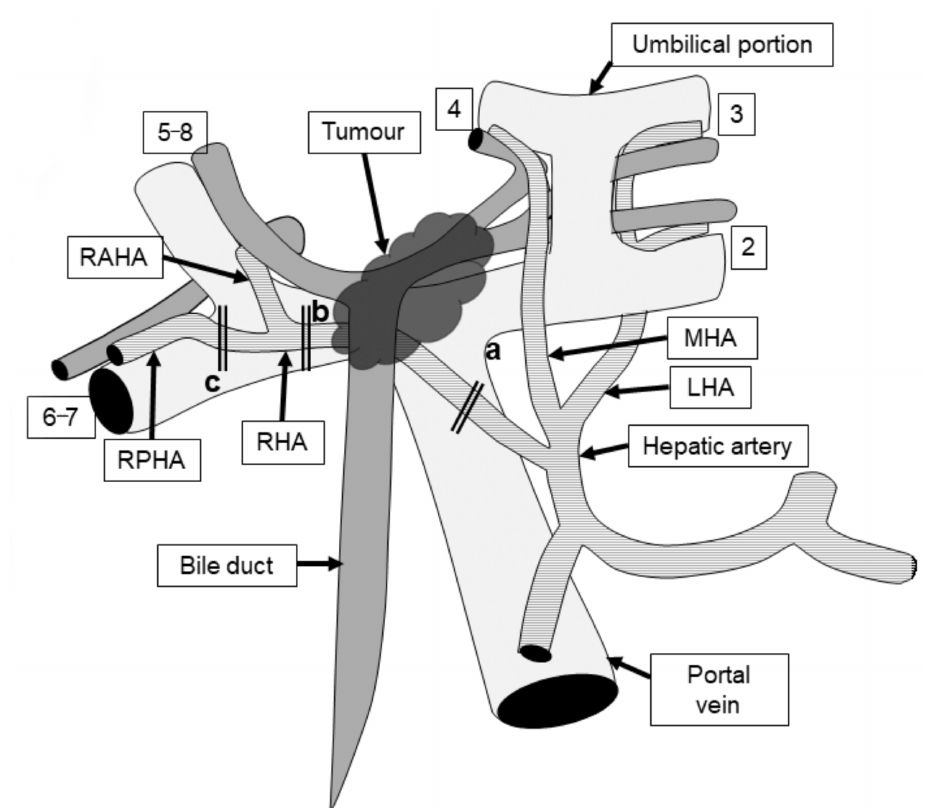
Figure 1. A schema of the anatomical relationship between the bile duct, hepatic artery, portal vein, and a Bismuth type 3B tumour in text-book-type anatomy. In left hepatectomy with hepatic artery resection (HAR), the right hepatic artery is cut proximal ( a ) and distal ( b ) to the tumour. In left trisectionectomy, the distal cut end of the hepatic artery can be placed further from the tumour at the right posterior hepatic artery ( c ). RHA: right hepatic artery; MHA: middle hepatic artery; LHA: left hepatic artery; RAHA: right anterior hepatic artery; and RPHA: right posterior hepatic artery. Numerals represent Cournand’s hepatic segments which the hepatic inflow vascular structures perfuse. (Reproduced with permission from Ref. [3]. 2022, LWW).